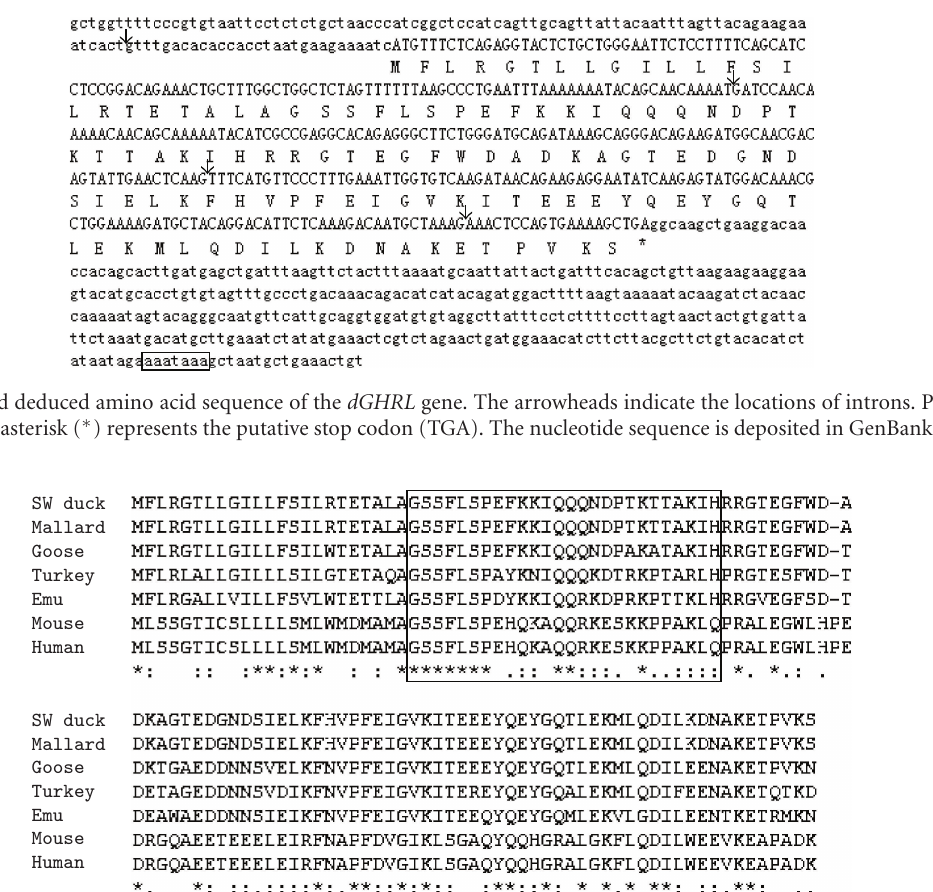
Figure 2: Alignment of GHRL sequences among 7 species. The mature peptides were